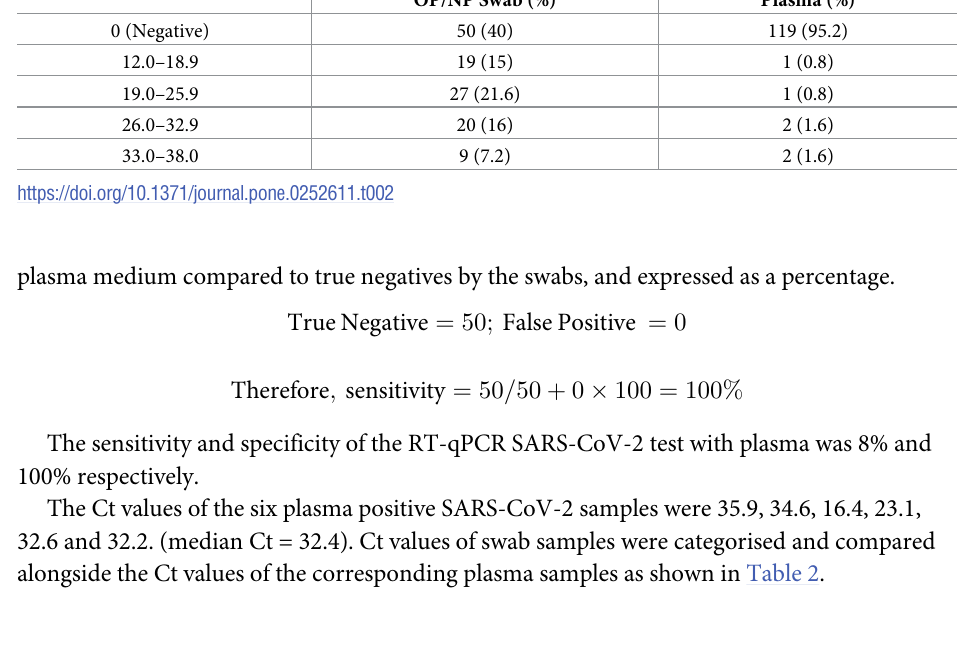
Table 2. Cycle threshold (Ct) values of COVID-19 swab samples in comparison with their corresponding plasma samples. Ct values